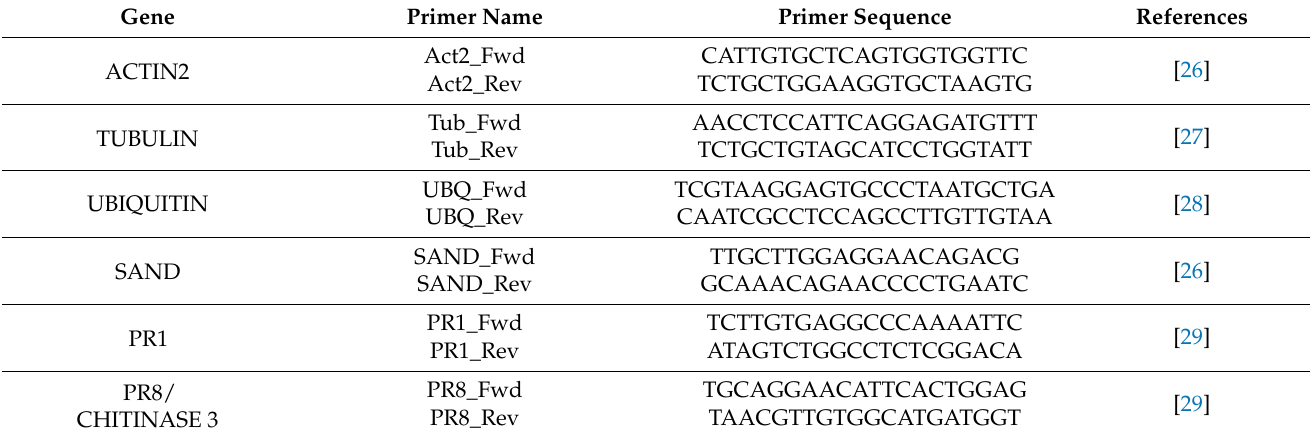
Table 1. Primers used for the RT-qPCR